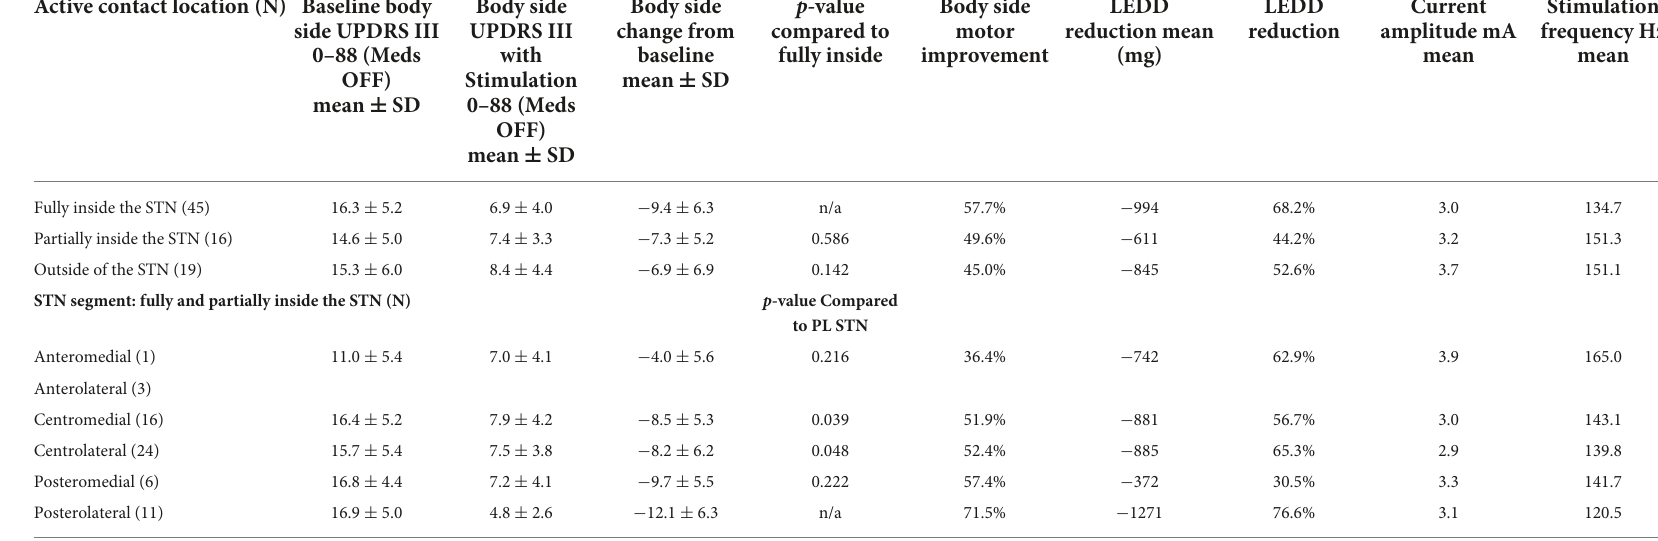
ANCOVA of stimulation scores adjusted for baseline. Comparison of hemi-body Unified Parkinson’s Disease Rating Scale (UPDRS) scores before and after deep brain stimulation (DBS) surgery, levodopa dosage (mg) and stimulation settings (mA, Hz)